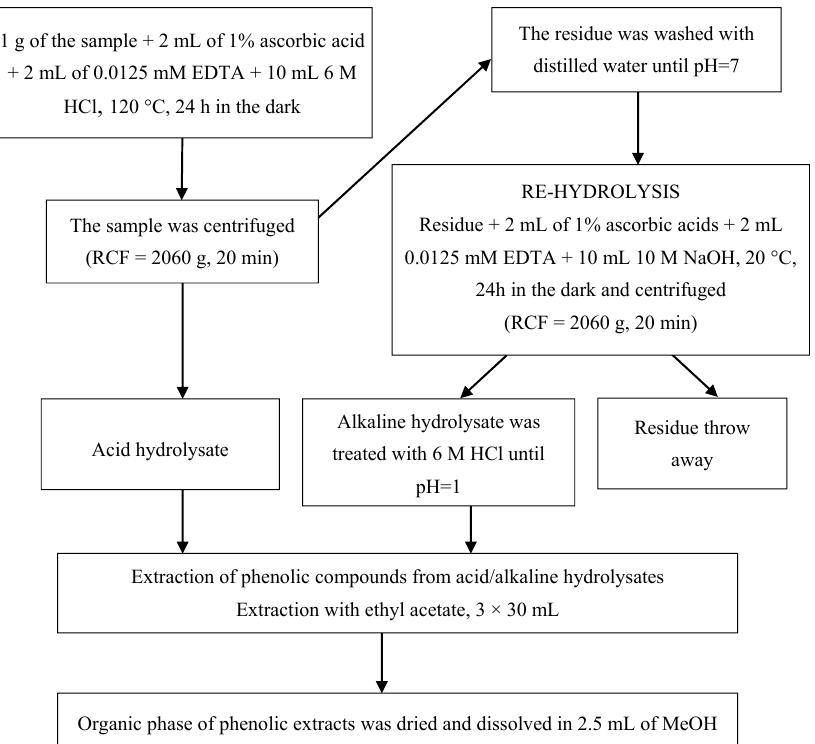
Figure 5. Extraction procedure for phenolic compounds from plant material and soil (modification of the methods described by Verma et al. 2009 and Ross et al. 2009).